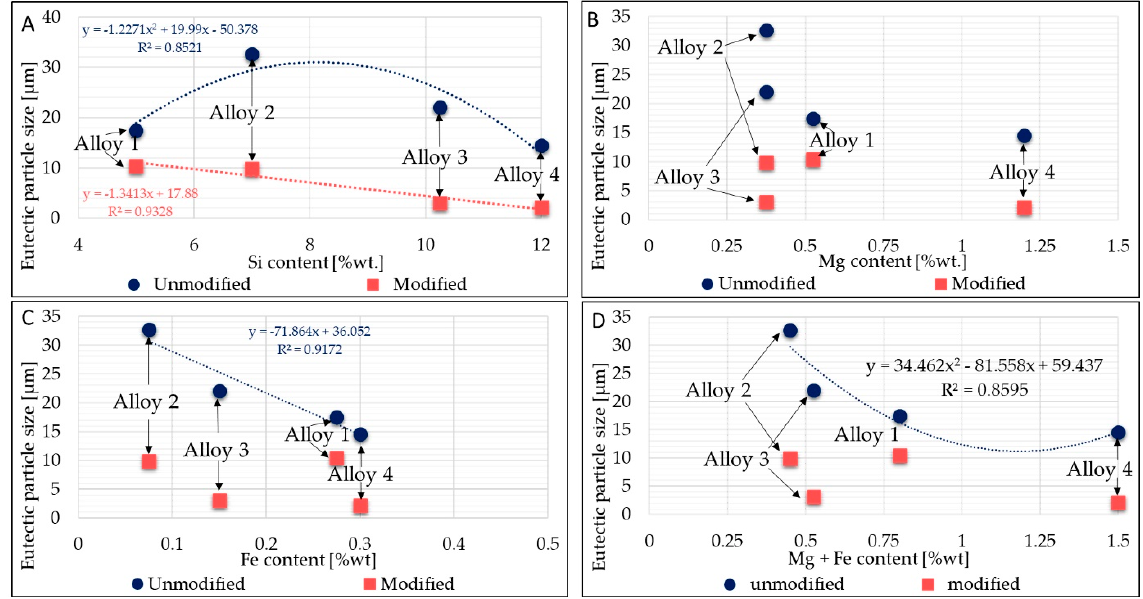
Figure 6. The relationships between particle size and Si, Mg, and Fe contents. ( A ). Relation between average Si content and eutectic particles’ size.; ( B ). Relation between average Mg content and eutectic particles’ size. ( C ). Relation between average Fe content and eutectic particles’ size. ( D ). Relation between average Mg + Fe content and eutectic particles’ size.